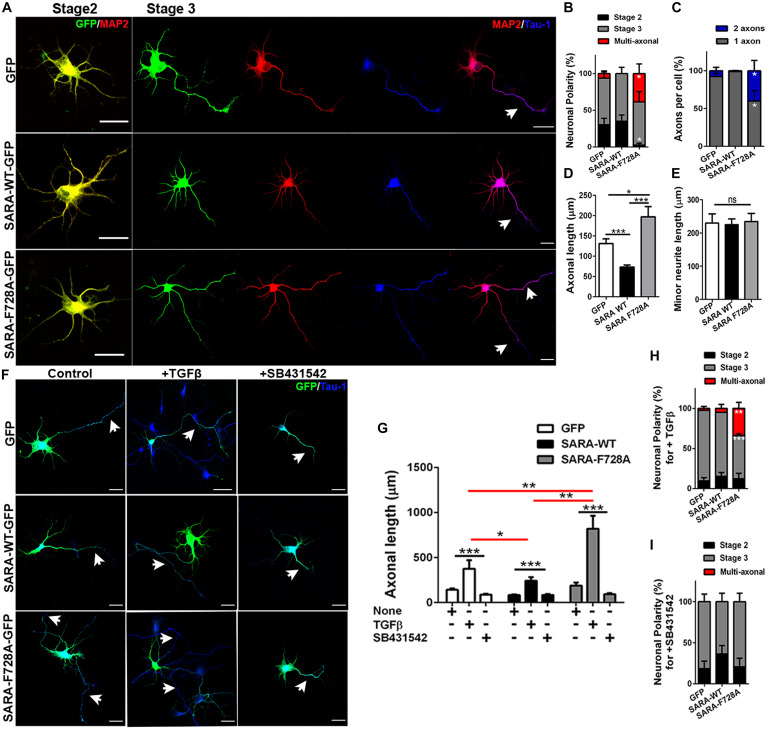
Contribution of SARA to TGFβ-dependent axonal growth during neuronal development. (A) Representative images of cultured hippocampal neurons transfected with GFP, SARA-WT-GFP, or SARA-F728A-GFP and immunostained to detect MAP2 (red channel) and Tau-1 (blue channel) epitopes. Briefly, neurons were transfected after plating and fixed at three DIV for IF staining. (B–E) Quantification of neuronal polarity acquisition (%) (stage 2: multipolar neurons; stage 3: polarized neurons and multiaxonic neurons) (B), number of axons per neuron (C), axonal length (D) and minor neurite length in 2 DIV neurons (MAP2-positive neurites 2–3 times shorter than Tau-1 positive axon) (E). *p < 0.05, **p < 0.005, ***p < 0.001 vs control (white column), ns: non-significant, ANOVA, Dunnett’s post-test (45 neurons were analyzed by condition). Scale bar: 20 μm. (F) Representative images of 3 DIV hippocampal neurons treated with TGFβ (2 ng/ml) or SB431542 (10 μM) (TβRI inhibitor) compared with control condition and immunostained to detect Tau-1 epitope (blue). (G) Quantification of axonal length after TGFβ (2 ng/ml) or SB431542 (10 μM) treatments in 3 DIV neurons. (H,I) Quantification of neuronal polarity acquisition (%) after either TGFβ (H) or SB431542 treatments (I) in 3 DIV neurons (stage 2: multipolar neurons; stage 3: polarized neurons and multiaxonic neurons). *p < 0.05, **p < 0.005, ***p < 0.001 vs control, ns: non-significant, ANOVA, Dunnett”s post-test (30 neurons were analyzed by condition). Arrows show axons in all images. Results represent the mean of three independent cultures (n = 3). Scale bar: 20 μm